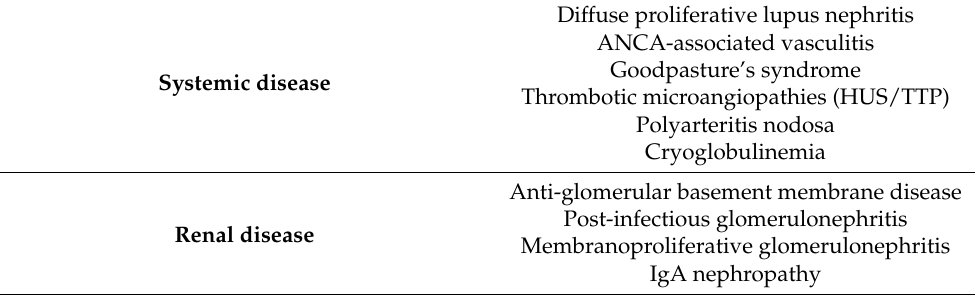
Table 3. Acute glomerular diseases causing